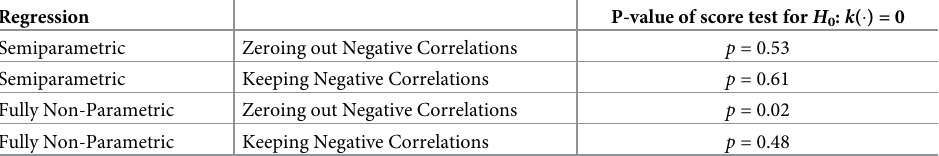
Table 2. Analysis of full COBRE